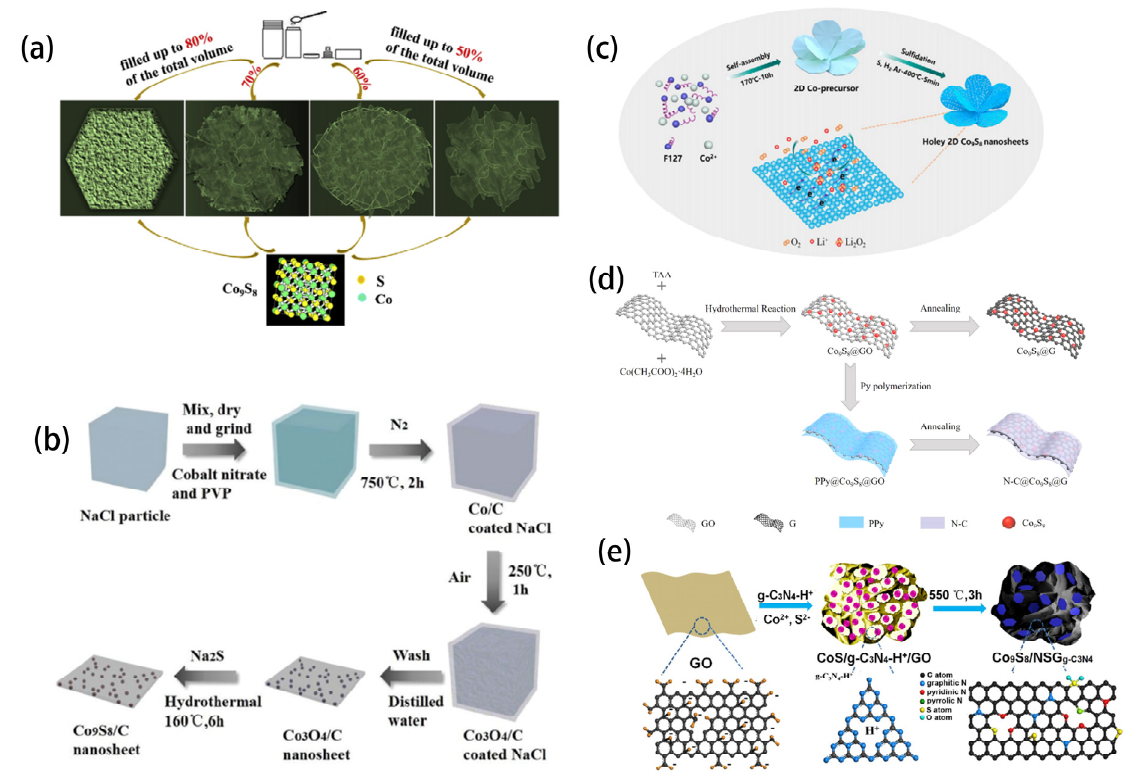
Figure 4. ( a ) Schematic illustration of the controllable synthesis of Co 9 S 8 catalysts. Reprinted with permission from Reference [42]. Copyright (2018) Elsevier Ltd. All rights reserved. ( b ) Schematic illustration of synthesis of Co 9 S 8 /C. Reprinted with permission from Reference [43]. Copyright (2019) Royal Society of Chemistry. ( c ) Schematic illustration for the synthesis of the holey Co 9 S 8 nanosheets Reprinted with permission from Reference [46]. Copyright (2020) Elsevier Ltd. All rights reserved. ( d ) Schematic illustration of synthesis of N–C@Co 9 S 8 @G sandwich structure. Reprinted with permission from Reference [49]. Copyright (2020) Elsevier Ltd. All rights reserved. ( e ) Schematic demonstration of the preparation process for Co 9 S 8 /NSG g-C3N4 . Reprinted with permission from Reference [51]. Copyright (2017) American Chemical Society.